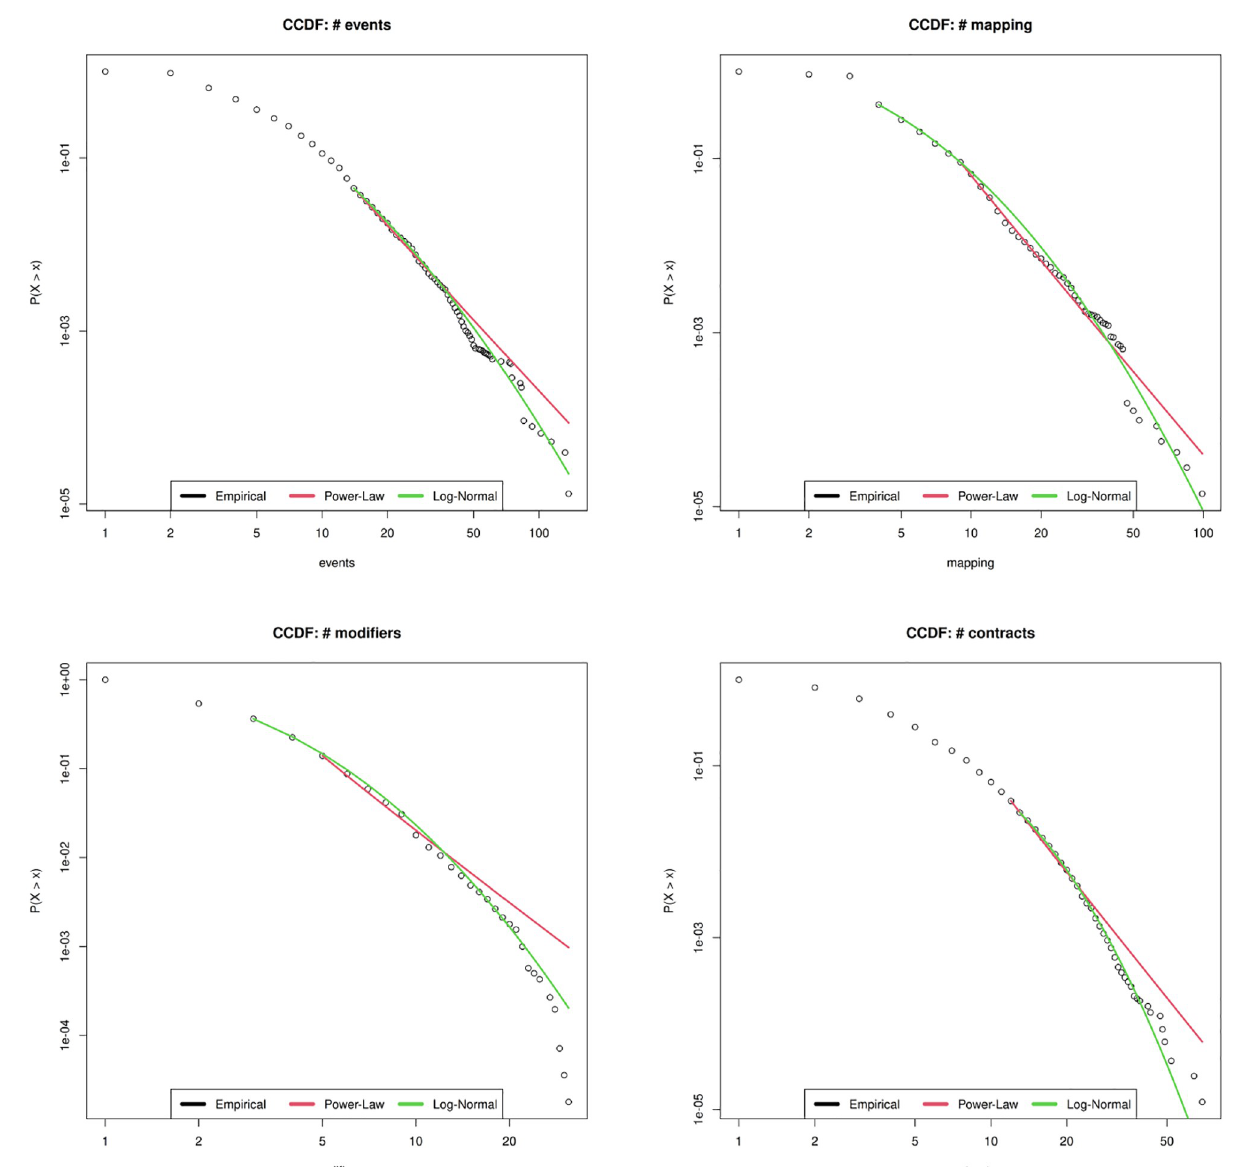
Fig 10. Power law and Log normal best fitting of the metrics Events, Mapping, Modifier and Contract.